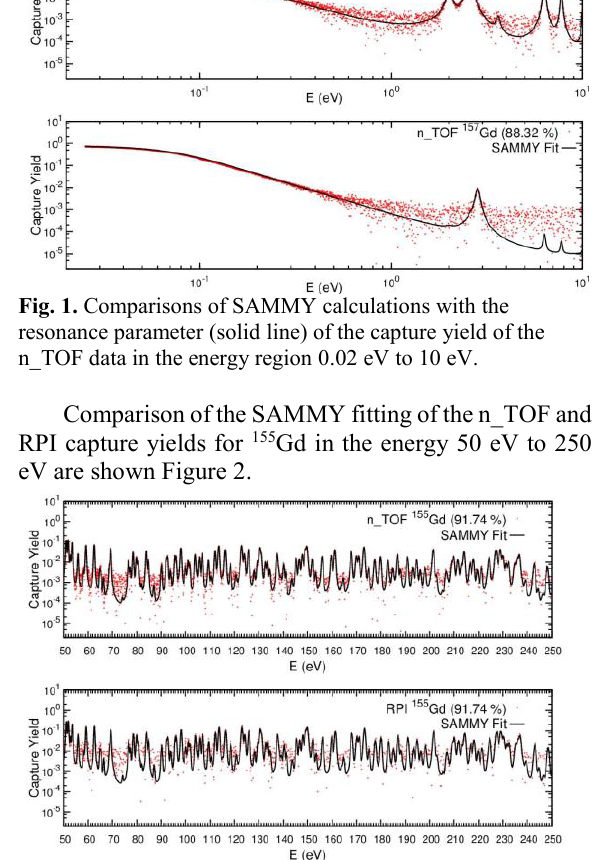
Fig. 2. Comparisons of SAMMY calculations with the resonance parameter (solid line) of the capture yield of the n_TOF and RPI data in the energy region 50 eV to 250 eV for 155